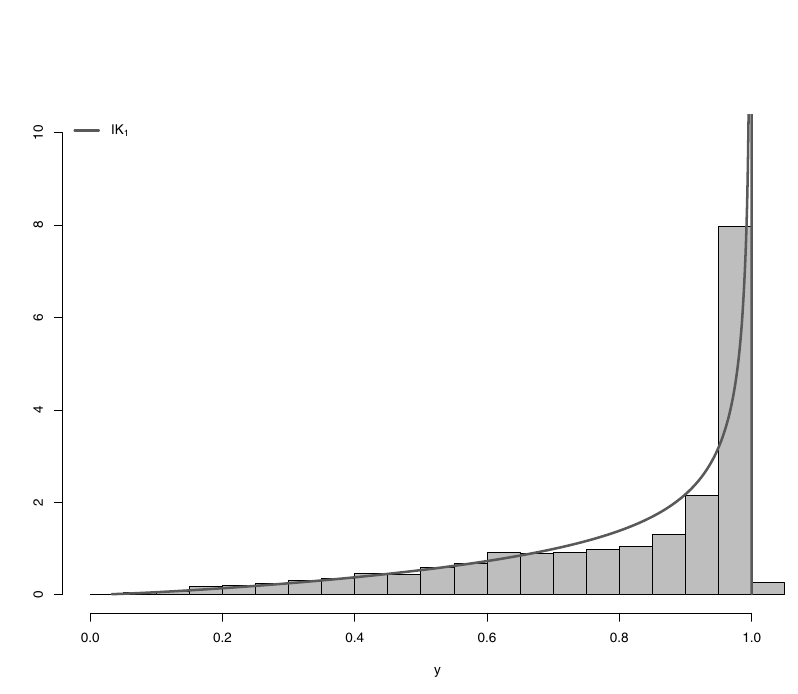
Figure 3 - Data histogram and fitted inflated Kumaraswamy